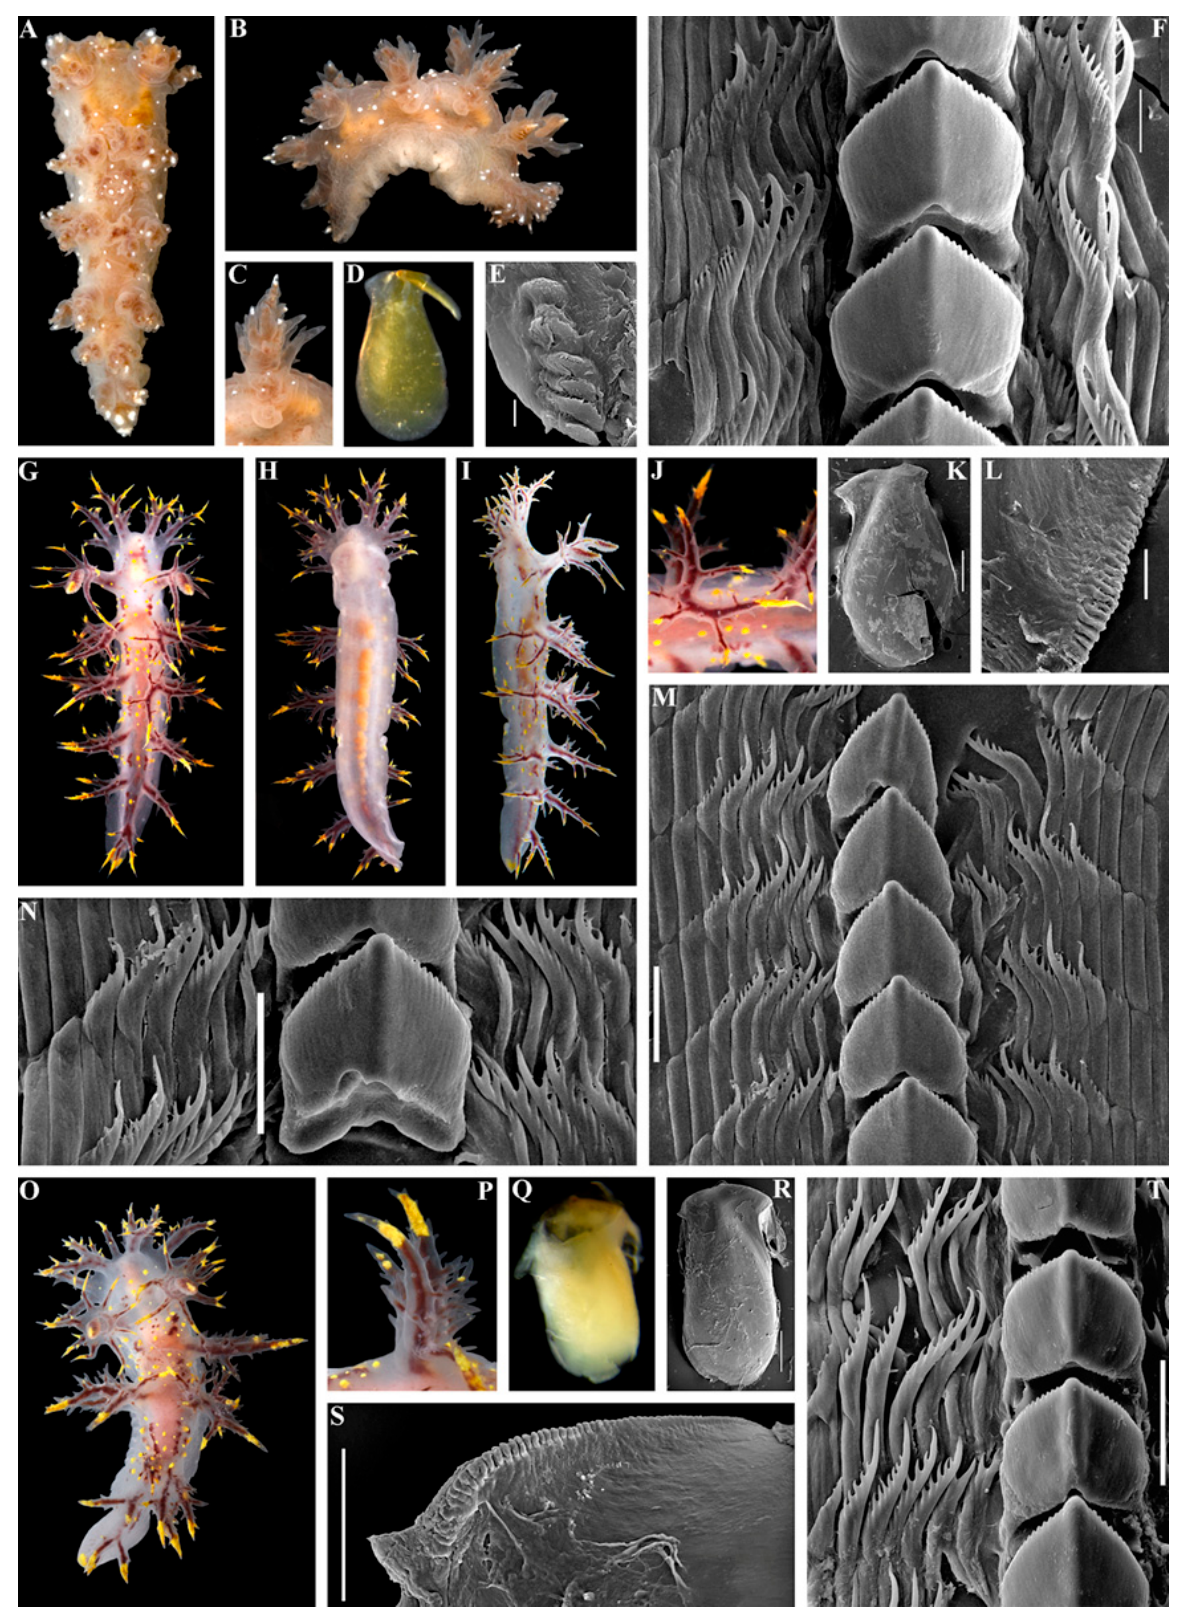
Figure 4. Dendronotus arcticus arcticus ( A – F ): ( A ) holotype D. arcticus arcticus in life (ZMMU Op-561) from the Laptev Sea, dorsal view; ( B ) paratype D. arcticus arcticus in life (ZMMU Op-562) from the Laptev Sea, lateral view; ( C ) dorsolateral appendages of the same paratype; ( D ) holotype jaws, light microscopy; ( E ) the same, discoid structures on the masticatory edge, SEM, scale bar 10 µm; ( F ) holotype, posterior part of radula, SEM, scale bar 30 µm. Dendronotus arcticus gartensis n. subsp. g–t: ( G ) holotype in life (ZMMU Op-802) from Norway, dorsal view; ( H ) holotype in life, ventral view; ( I ) the same, lateral view; ( J ) the same, dorsolateral appendages; ( K ) holotype, jaws, SEM, scale bar, 500 µm; ( L ) the same, discoid structures on the masticatory edge SEM, scale bar 50 µm; ( M ) holotype, radula, posterior part, SEM, scale bar, 50 µm; ( N ) the same, posterior part, de- tails, SEM, scale bar 50 µm; ( O ) paratype ZMMU Op-807 from Norway, dorsal view; ( P ) the same, dorsolateral appendages; ( Q ) paratype ZMMU Op-807, jaws, light microscopy; ( R ) the same, jaws, SEM, scale bar, 500 µm; ( S ) the same, discoid structures on the masticatory edge, SEM, scale bar 200 µm; ( T ) radula, posterior part, SEM, scale bar 50 µm. Photographs of living animals by Viktor V. Grøtan, Alexander Martynov and Olga Zimina. SEM micrographs and light microscopy images by Alexander Martynov.